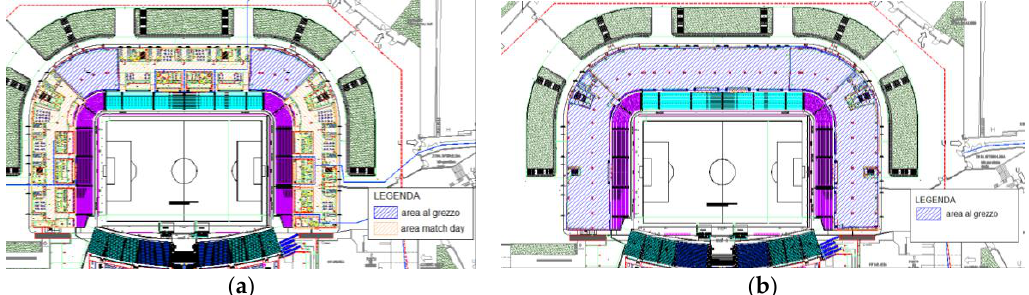
Figure 4. Dacia Arena, areas served by the new system; from the left: ( a ) Level 0; ( b ) Level − 1.